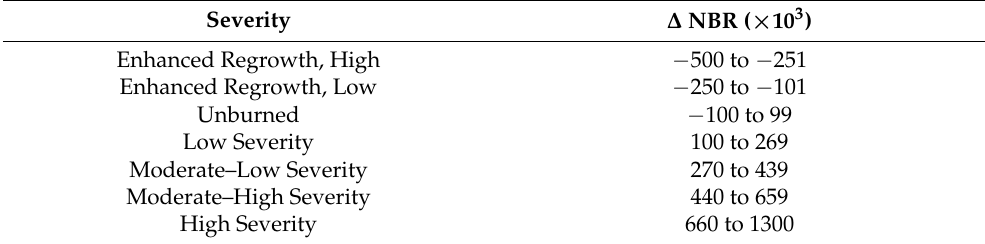
Table 1. Burning severity